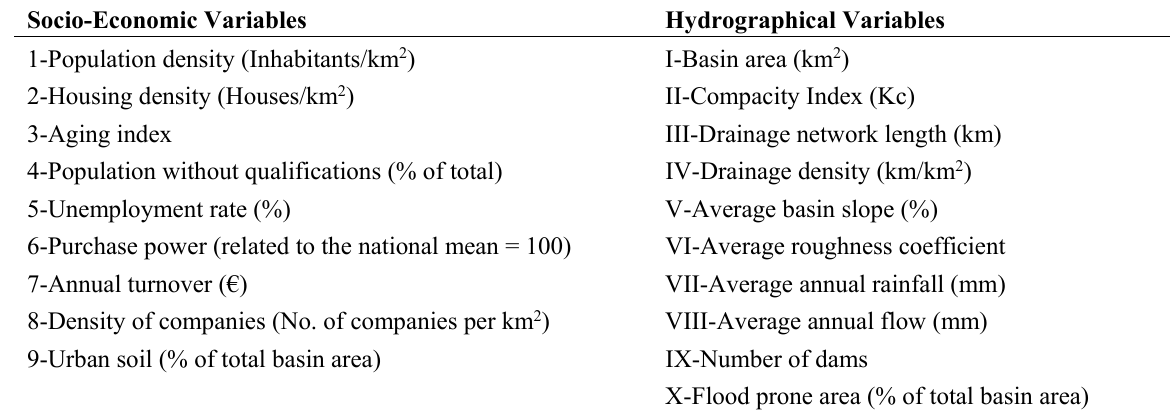
Table 2. Variables considered in the analysis of the territorial basins context. Source: Hydrographical Basin Management Plan—Vouga, Mondego and Lis basins